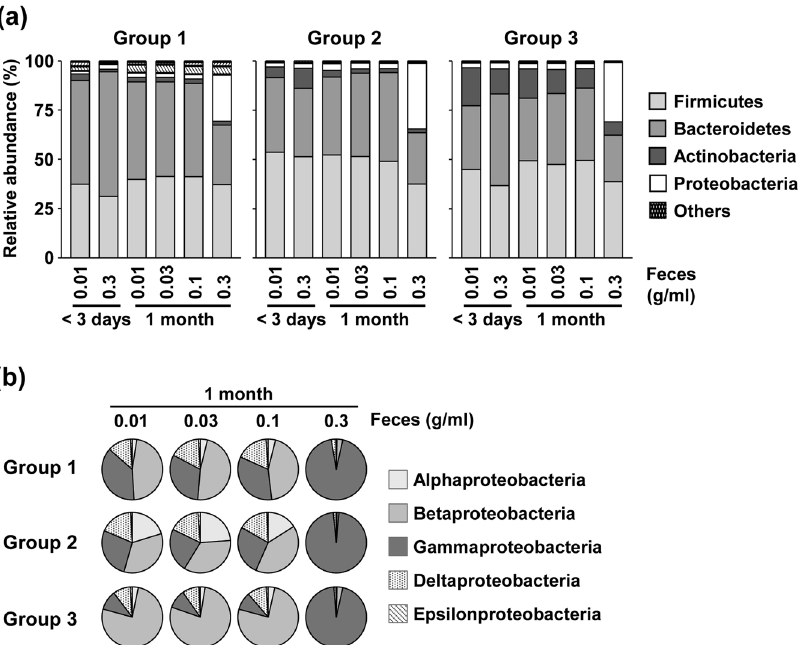
Figure 3. Effects of fecal concentration on microbial composition in fecal samples stored in GuSCN solution. ( a ) Microbial composition at the phylum level in GuSCN solutions containing different concentrations of feces (0.01–0.3 g/ml); Aliquots (0.01–0.3 g) of fecal samples were in 15 ml vials containing 1 ml of GuSCN solution. DNA was extracted within 3 days or after storage for one month at room temperature. ( b ) Class abundance of Proteobacteria after storage for one month at room temperature, graphed according to fecal concentration.